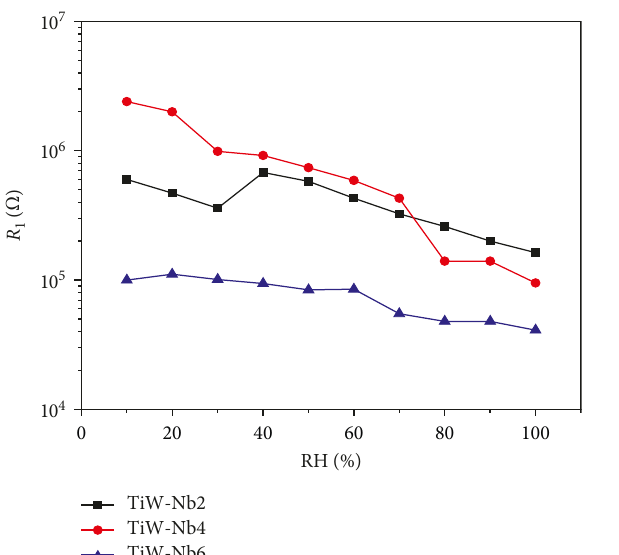
Figure 8: Dependence of R 1 —fitting parameter of equivalent circuit with RH variation at different doping